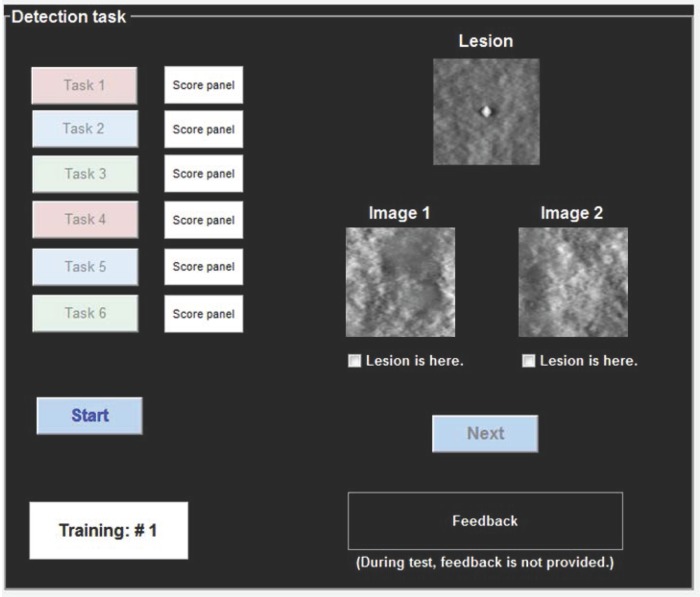
The binary detection task for the human observer study with respect to six detection tasks.